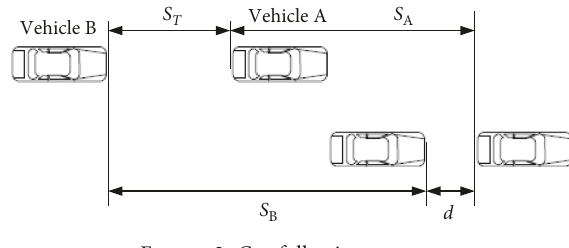
Figure 2: Car-following